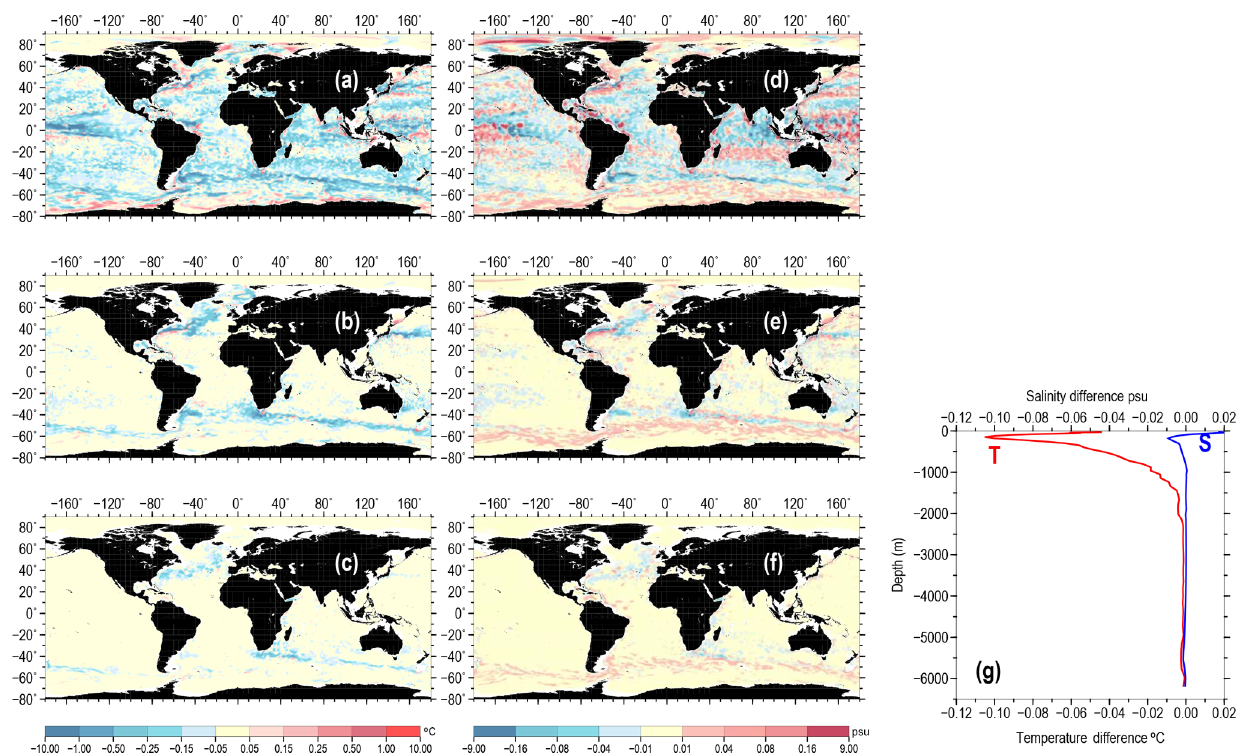
Figure 8. Temperature (a–c) and salinity (d–f) differences between the isopycnally averaged and isobarically averaged WAGHC climatolo- gies for selected depth levels in January: 150m (a, d) , 518m (b, e) , 1050m (c, f) ; and area-averaged differences vs. depth (g)